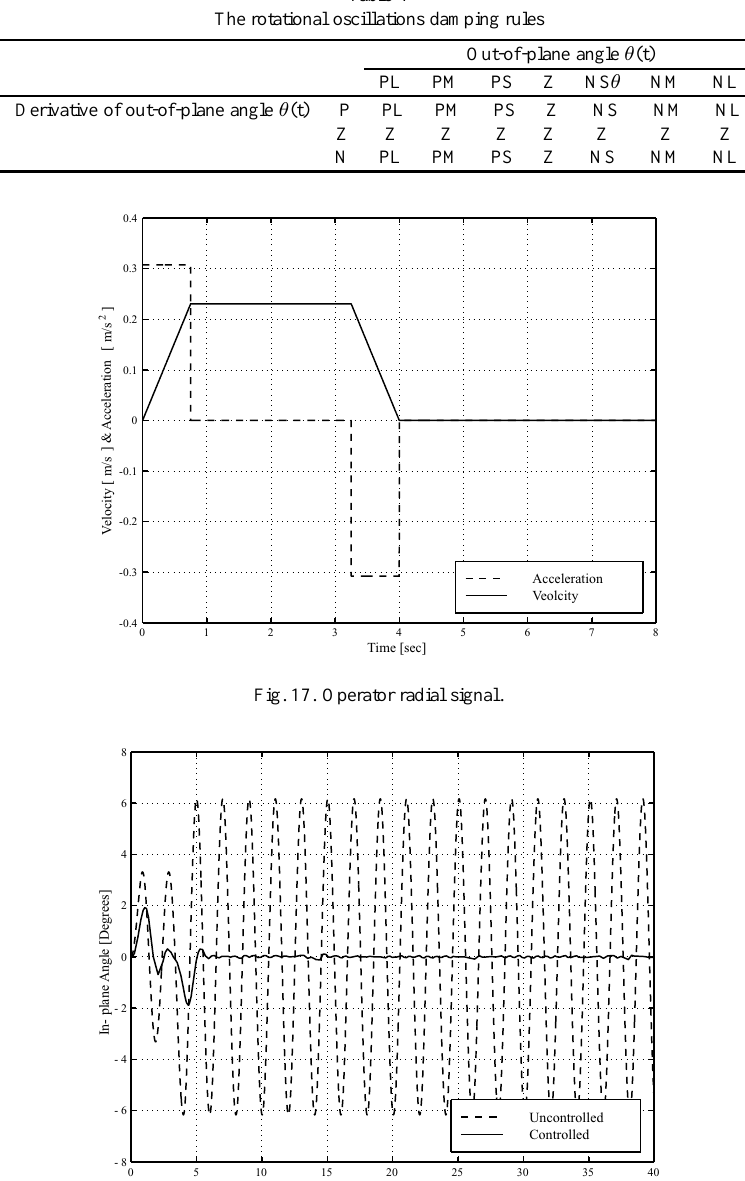
Fig. 18. In-plane angle φ ( t ) for the gantry case using the fuzzy controller.]Uncontrolled vs controlled in-plane oscillation angle φ ( t ) for the gantry case using the fuzzy controller. controller. The outputs of the two FIEs are input to a variable-share mixing block, where the output from the tracking FIE is multiplied by a factor K and the oscillation damping FIE output is multiplied by 1 − K . Then, the scaled outputs are added to obtain the controller output